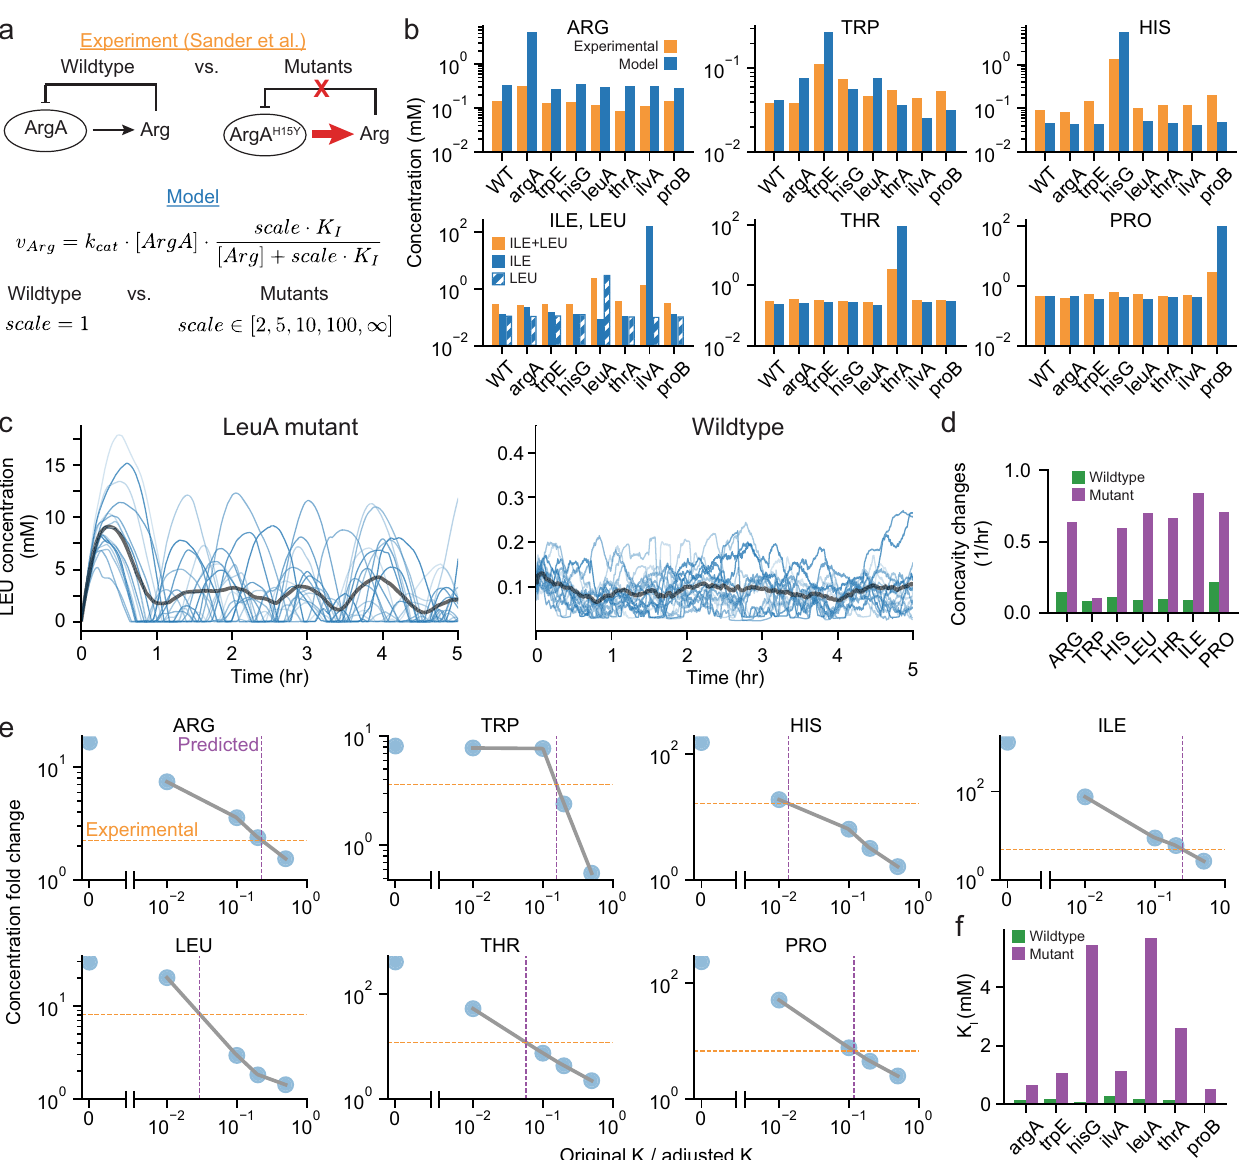
Fig. 4 Simulations with amino acid allosteric inhibition removed provide amino acid concentration predictions that are comparable to experimental results. a Schematic showing the effect of mutants experimentally, where point mutations remove allosteric inhibition of the amino acid end-product on a pathway enzyme leading to higher amino acid concentrations, and in the model, where the mutation is represented as a scaling factor that increases the end-product inhibitory concentration ( K I ) that increases the rate of amino acid production. b Amino acid concentrations in wild-type cells and mutants with allosteric inhibition removed from experiments (orange, Sander et al. 35 ) and the model with scale = in fi nity (blue). Note that isoleucine and leucine cannot be distinguished experimentally but have distinct concentrations in the model (solid: isoleucine, hatched: leucine). See Supplementary Table 4 for the standard deviation for simulations. c Time series for leucine concentrations for LeuA mutant without allosteric inhibition showing oscillatory concentrations without the fast feedback of enzyme inhibition compared to the wildtype with allosteric inhibition. Blue traces show individual cell lineages and the average is shown in gray. d Average frequency of concavity changes for each amino acid concentration from wildtype simulations and the mutant simulations corresponding to the amino acid. This is a proxy for 1/period if the fl uctuations were regular and periodic. e Predictions of the extent of inhibition removal based on the concentration fold changes in experiments compared to simulation fold changes. f Allosteric feedback inhibition constants for each enzyme for reported wildtype value (green) and effective K I in mutants based on analysis in ( d ) (purple). Simulation data comes from 16 generations and 16 initial seeds for ( b ), ( c ), and ( d ) and 8 generations and 4 initial seeds for ( e ) and ( f